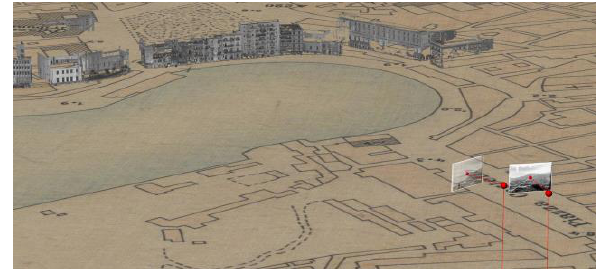
Figure 4: Cameras poses in the 3D scene.